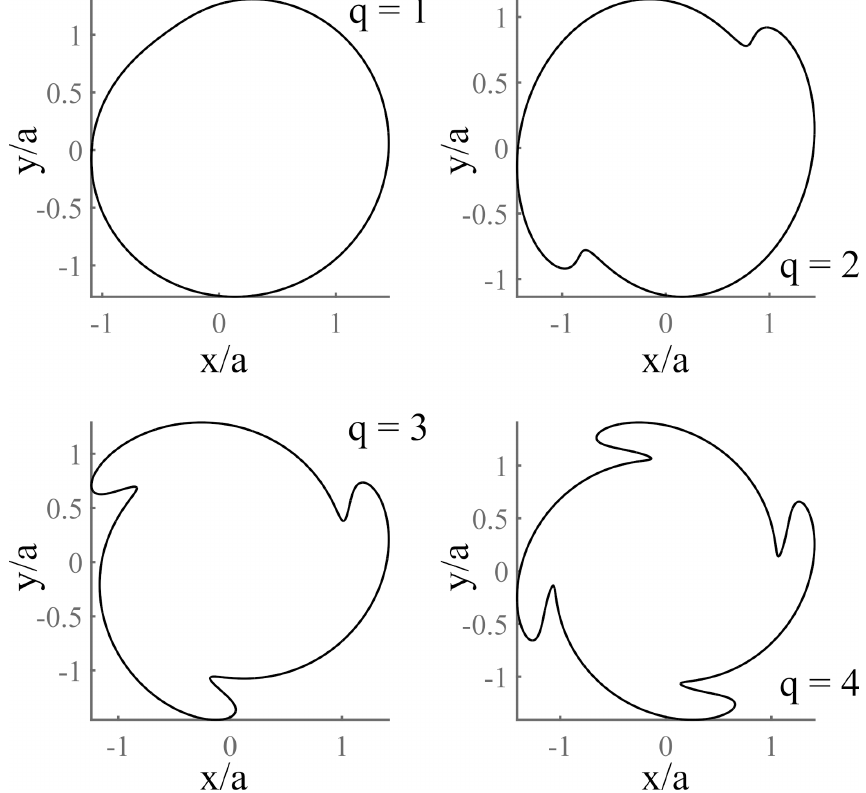
Figure 5. Solutions of system of Equations (14a) and (14b), for integer mode values q = 1 to 4 (see